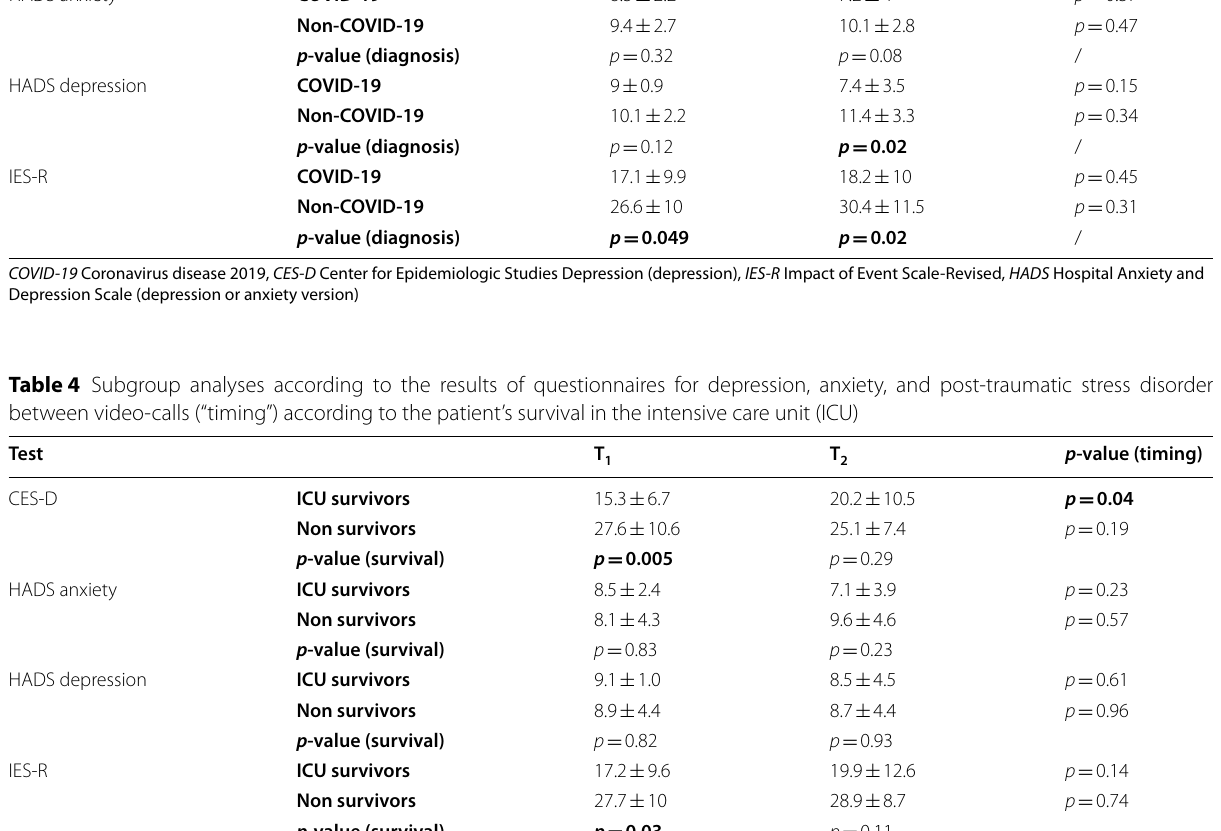
CES-D Center for Epidemiologic Studies Depression (depression), IES-R Impact of Event Scale-Revised, HADS Hospital Anxiety and Depression Scale (depression or anxiety